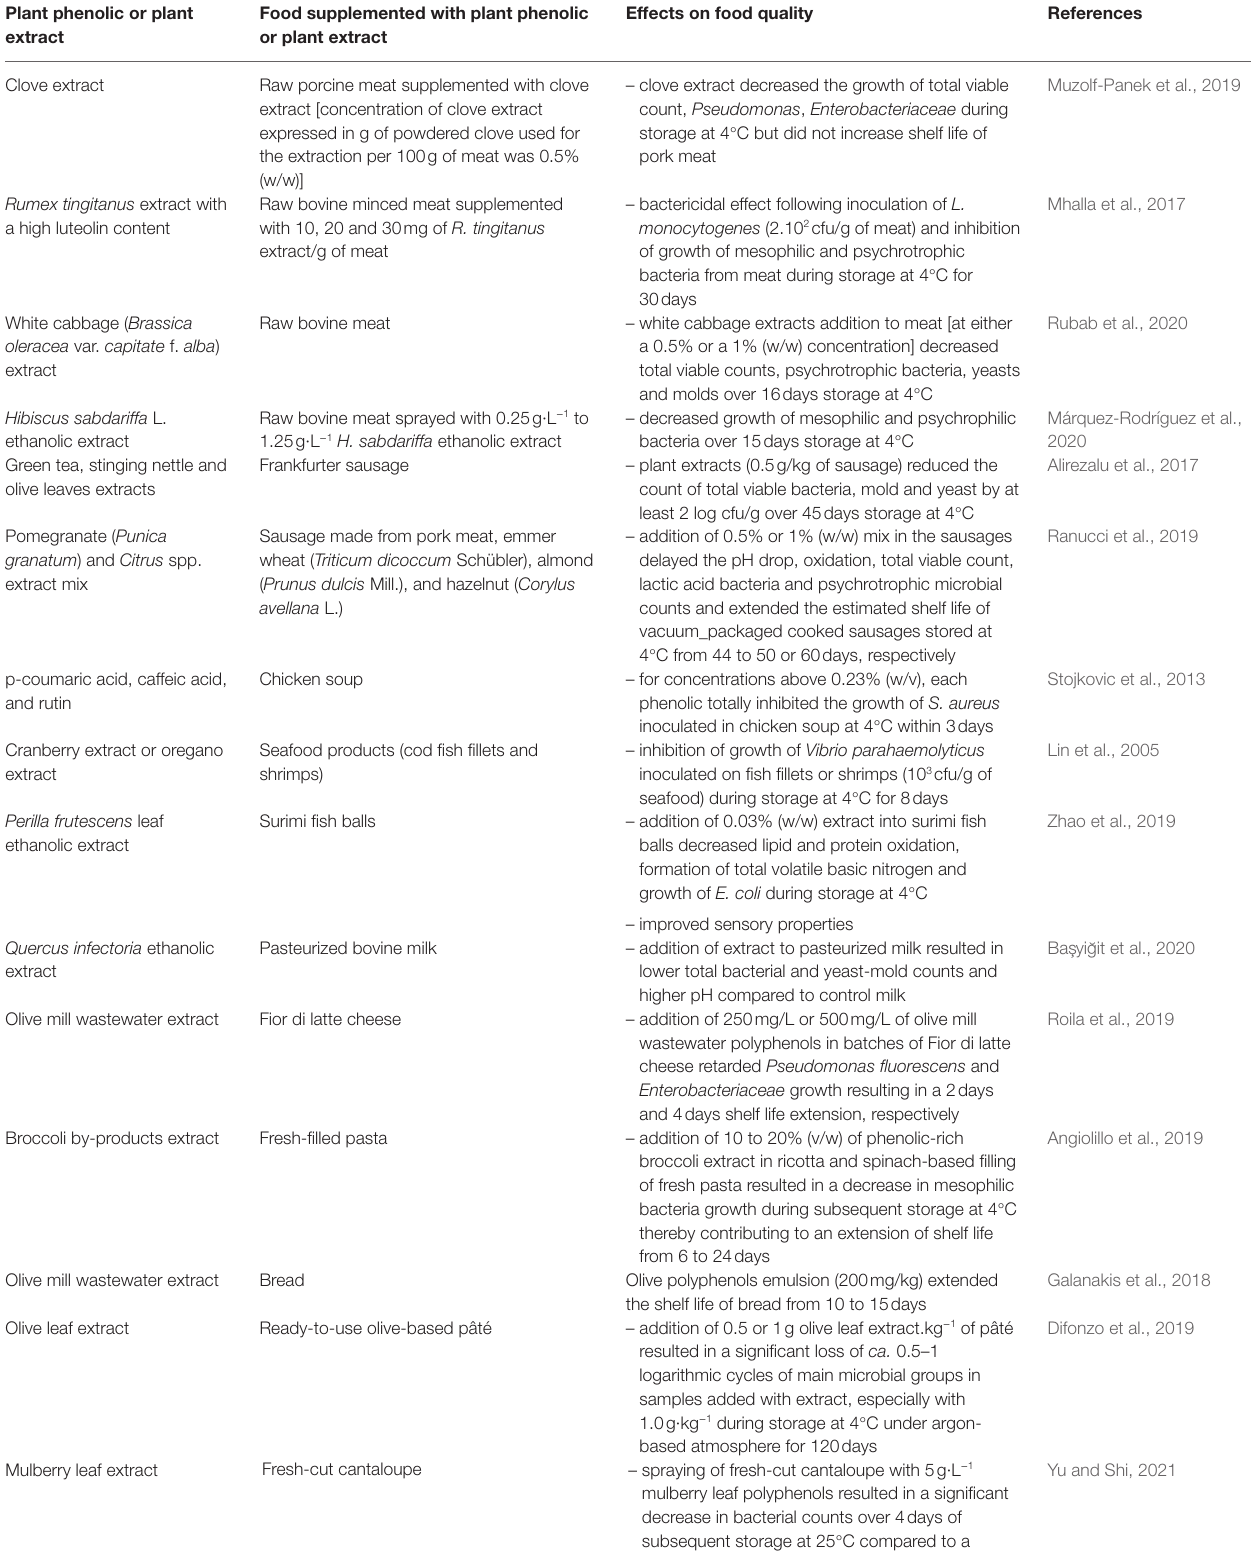
TABLE 3 | Examples of phenolic-rich plant extracts or plant phenolics effectively inhibiting the growth of unwanted microorganisms in food matrices. Plant phenolic or plant